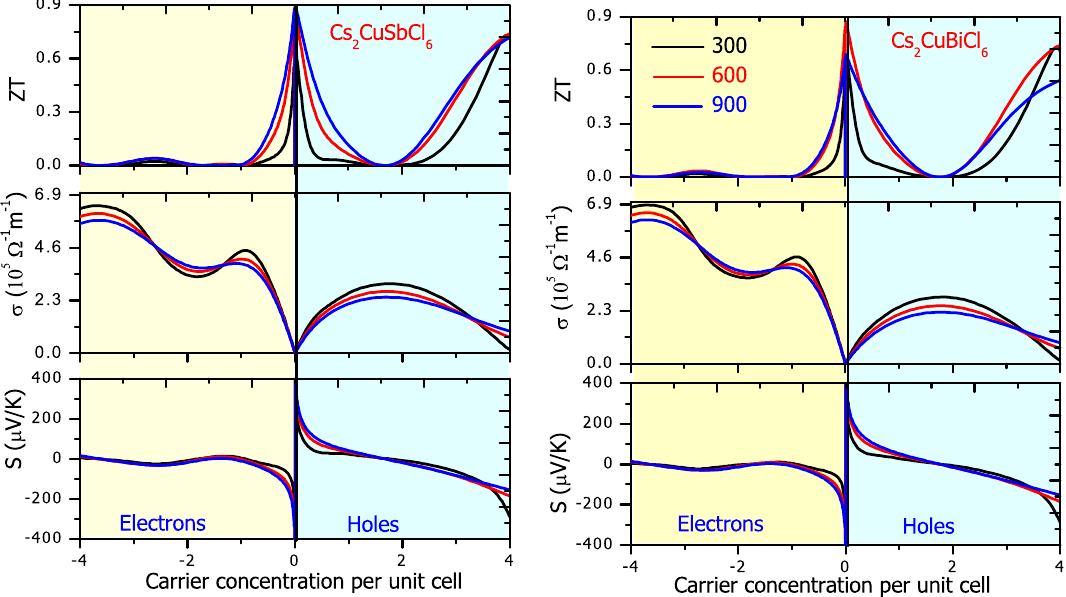
Figure 6. Variation in Seebeck coefficient, conductivity and ZT with electron and hole concentration. Negative carrier concentration is meant for electrons and positive for holes. Different colors are used to distinguish the temperature: Black-300 K; Red-600 K; and Blue-900